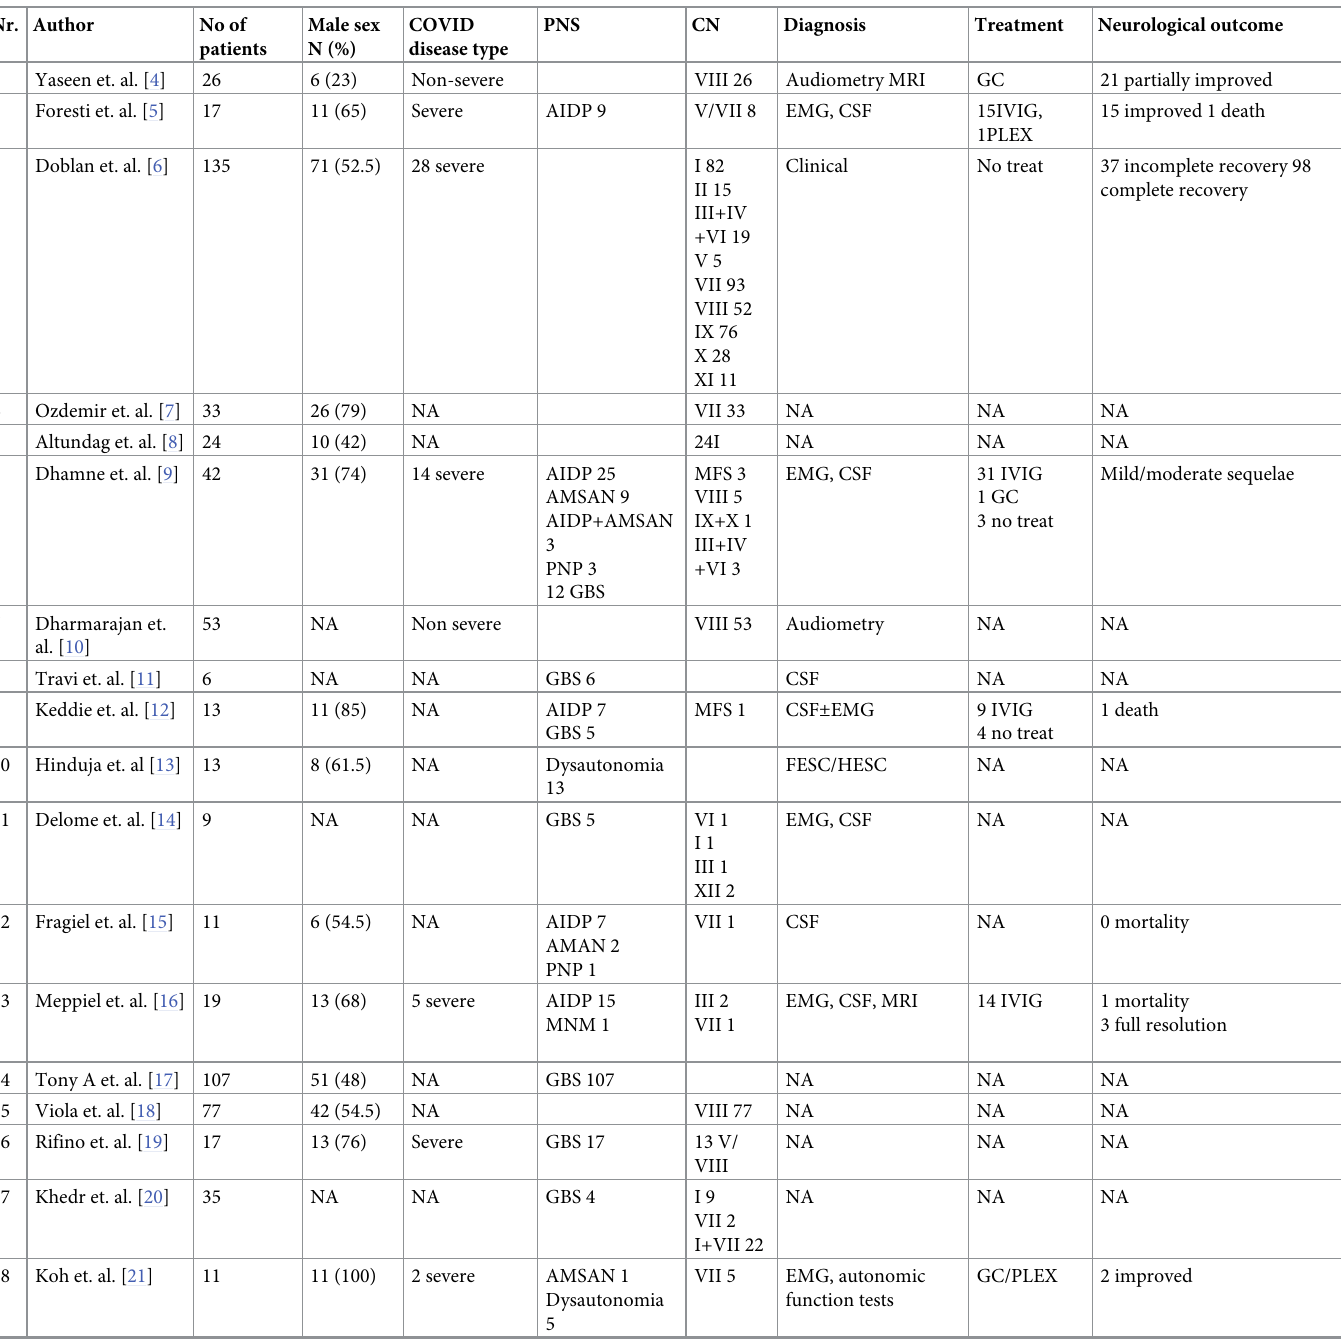
Table 1. Demographics and characteristics of peripheral nervous system involvement in large case series